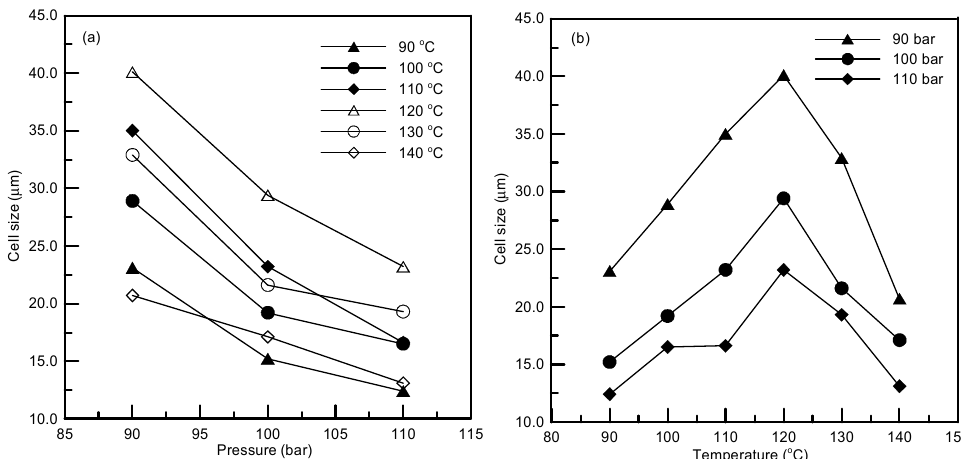
Figure 7. Comparison of cell structure of TPU foams obtained from different saturation temperature and saturation pressure.